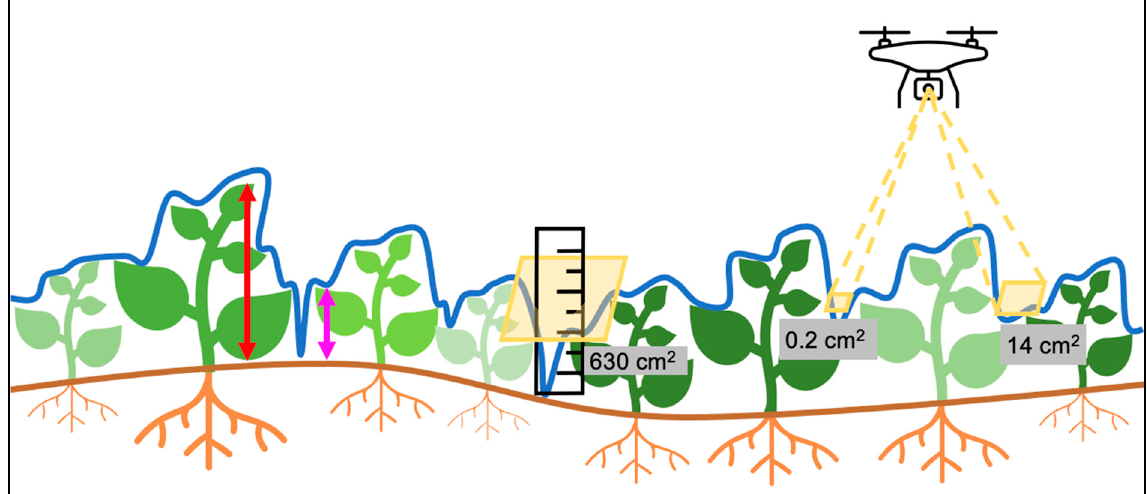
Figure 1. Illustration of the digital surface model (blue line) following the top surface of the vegetation and the digital terrain model (brown line) following the terrain below. The red arrow indicates an example of the plant height, measured between the ground and the apical part of the plant. The pink arrow indicates an example of canopy height, measured between the ground and the visible top of the plants or the ground, where the ground is uncovered. The three yellow squares illustrate the resolution of the different methods for determining canopy height, with the ruler-based method showing the coarsest resolution and HR imaging the finest resolution.